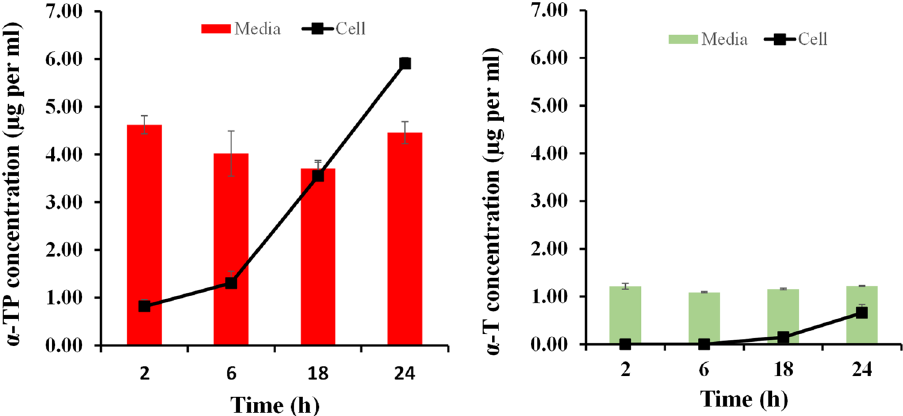
Figure 8. The metabolism of tocopherol phosphate (α-TP) into tocopherol (α-T) in HCAT cells after dosing in cell culture media. ( a ) The concentration of α-TP in the cell culture media and cell lysates over time after the dosing of the cells with 133 µg per mL of α-TP. ( b ) The concentration of α-T in the cell culture media and cell lysates over time after the dosing of the cells with 133 µg per mL of α-TP. Data represents mean ± one standard deviation (n =